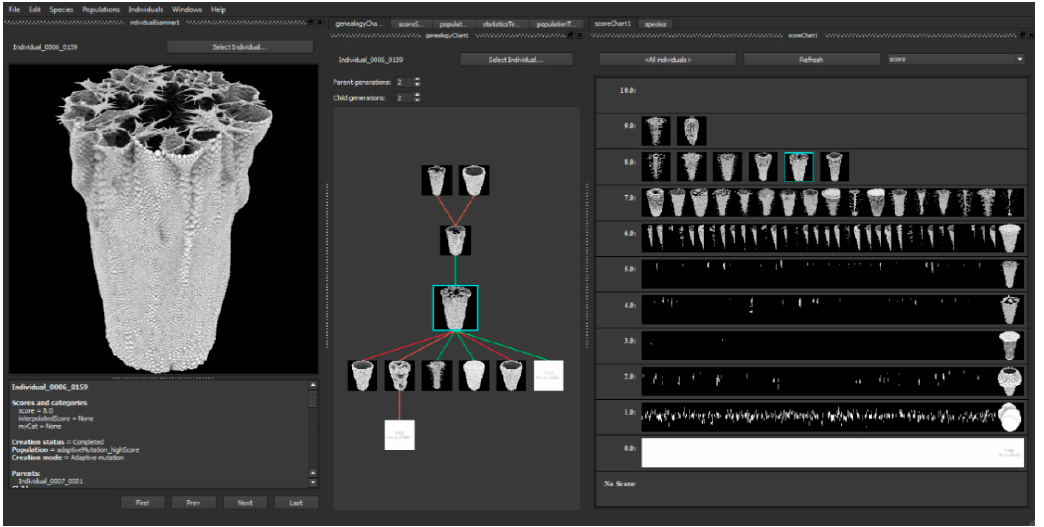
Figure 3. Species Explorer user interface.